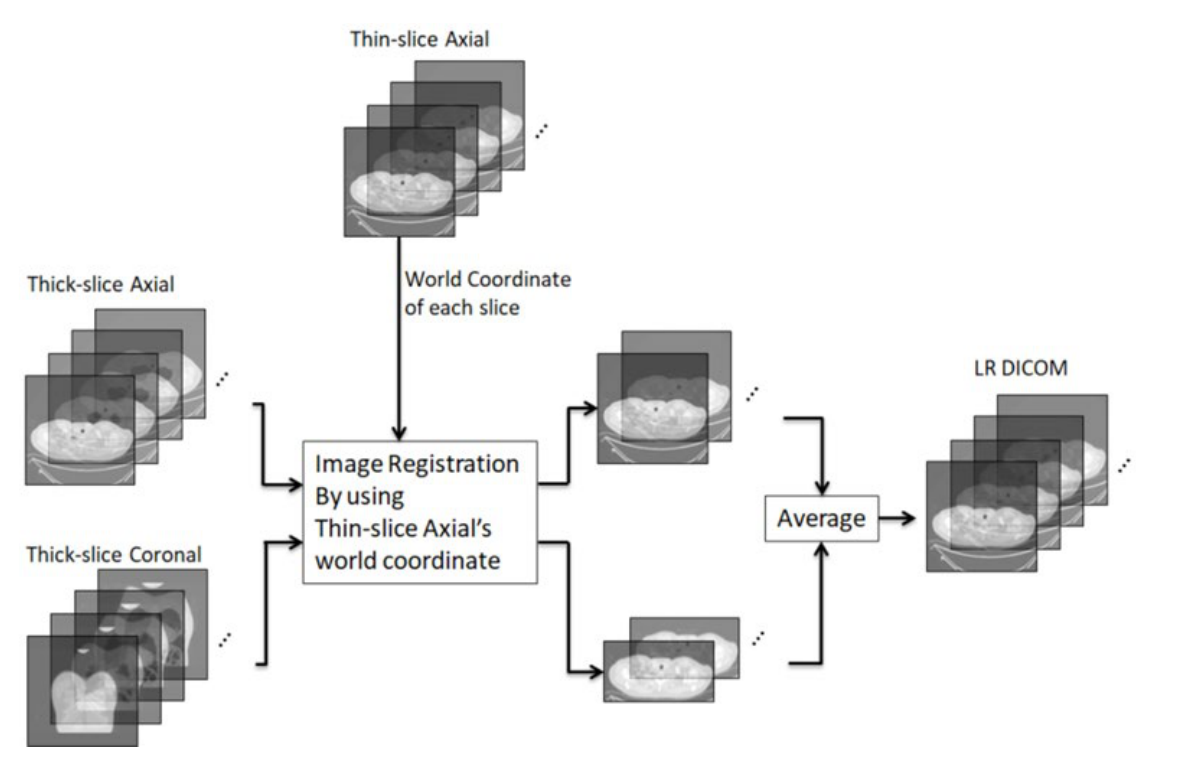
Figure 5. Process flow for generating LR DICOM data. From right to left of the figure, we performed image registration for the axial thick slices and coronal thick slices. Then, we combined the slices through averaging in 3D space to generate LR DICOM. The LR DICOM serves as the input for training and testing SR models.